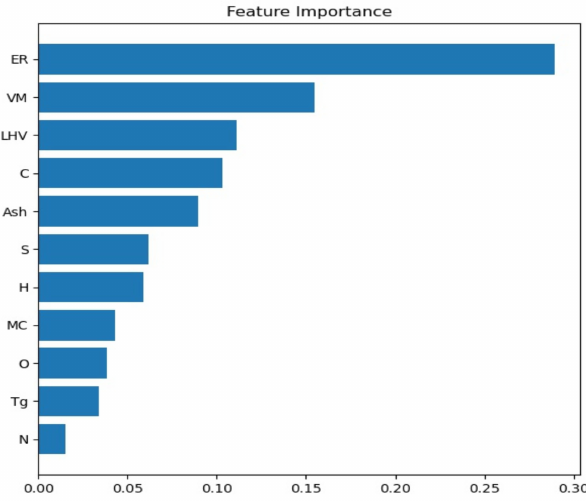
Figure 5. Feature importance detailed scores of the H 2